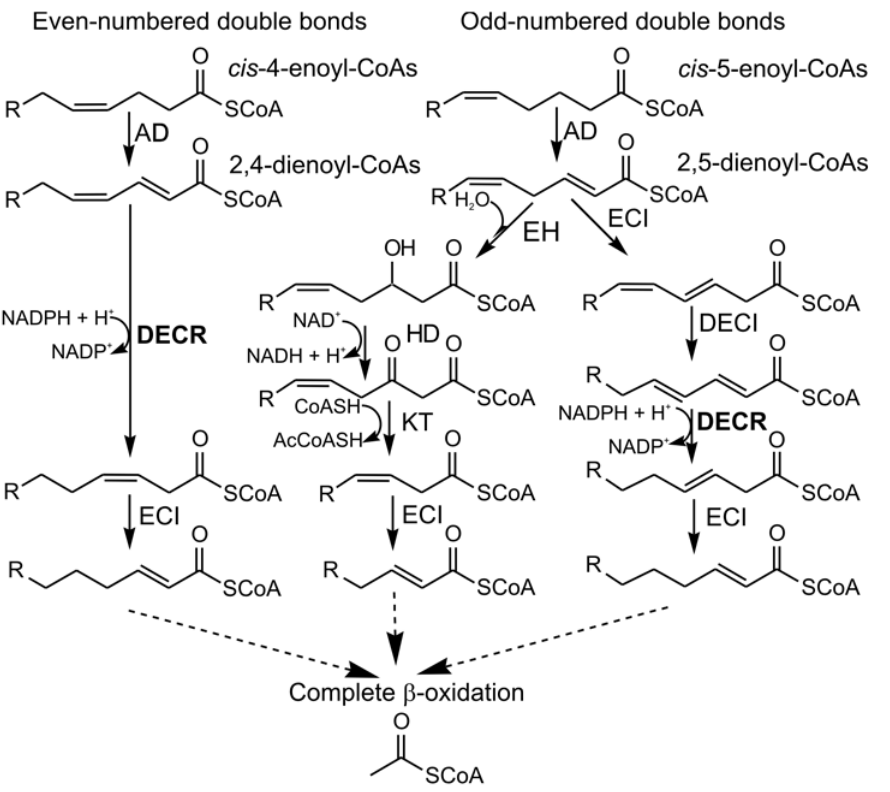
Figure 1. b -oxidation of fatty acids with double bonds at even- or odd-numbered positions in mitochondria. Degradation of fatty acids with even-numbered double bonds results in 2,4-dienoyl-CoA esters, which are oxidized as shown on the left. 2,5-dienoyl-CoA esters arising from odd-numbered double bonds can be oxidized either via an isomerase-dependent pathway (middle) or via a reductase-dependent pathway (right). AD, acyl-CoA dehydrogenase (EC 1.3.3.6, EC 1.3.99.3, EC 1.3.99.13 or EC 1.3.99.-); EH, enoyl-CoA hydratase (EC 4.1.2.17 or EC 4.2.1.74); HD, 3- hydroxyacyl-CoA dehydrogenase (EC 1.1.1.35 or EC 1.1.1.211); KT, 3-ketoacyl thiolase (EC 2.3.1.16) ; ECI, D 3 , D 2 -enoyl isomerase (EC 5.3.3.8); DECI, D 3,5 , D 2,4 -dienoyl-CoA isomerase (no EC number available); DECR (shown in bold), 2,4-dienoyl-CoA reductase (EC